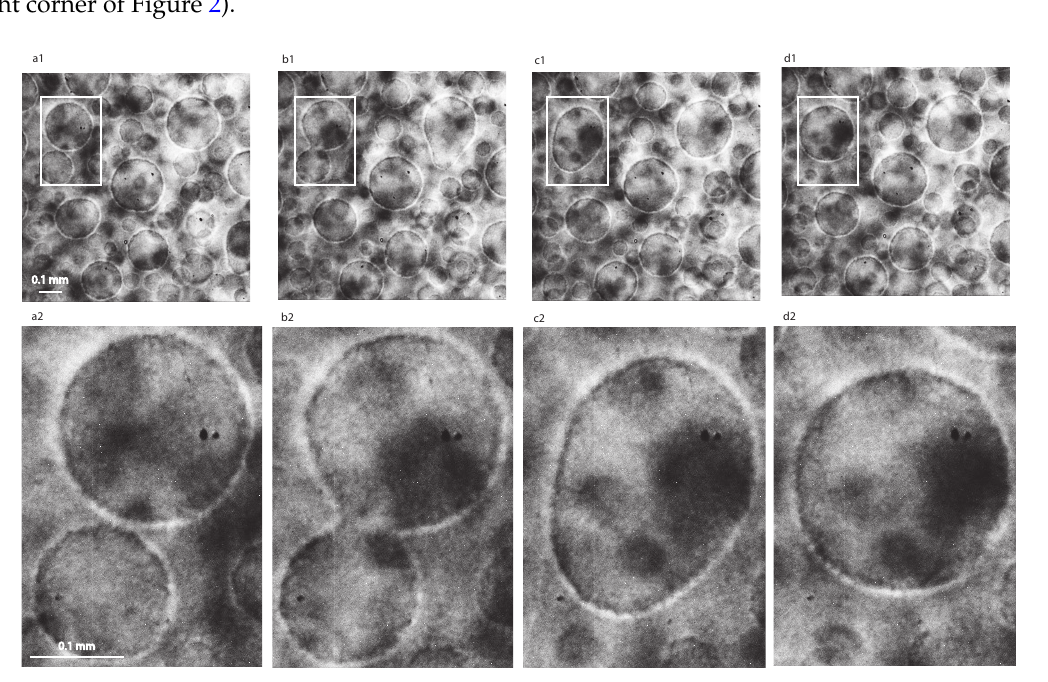
Figure 2. Binary collisions between vapor bubbles in narrow filed of view (NFOV) images at successive times ( a ) 6607.3 s; ( b ) 6879.7 s; ( c ) 6970.4 s; and ( d ) 7061.2 s. The highlighted white-bordered